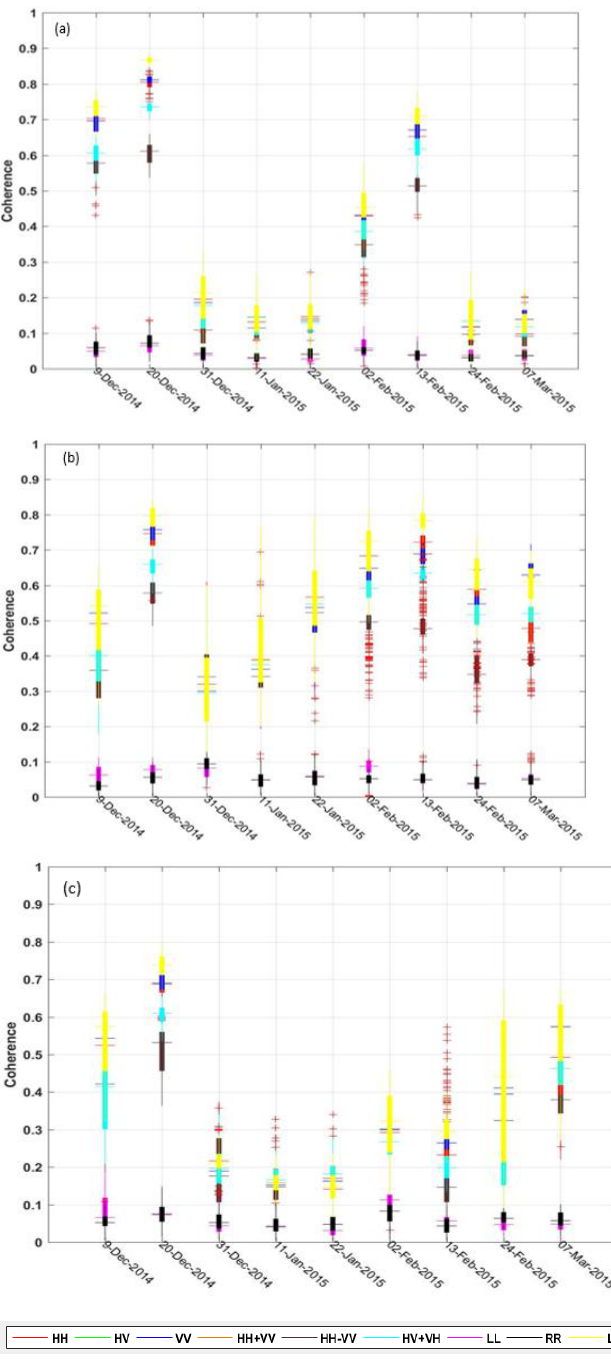
Figure 3 Whisker plots showing trend for Pol-InSAR Coherence in all possible polarizations. (a) Represents the trend for an Uncut teak plot, (b) represents trend for teak plot cut in January and (c) represents trend for teak plantation cut in February Among the 9 pair time-series, those data sets with perpendicular baseline more than 300 m were chosen in order to remove the effect of smaller baseline on coherence. The stratified plots (uncut, January cut and February cut) shown in figure 1